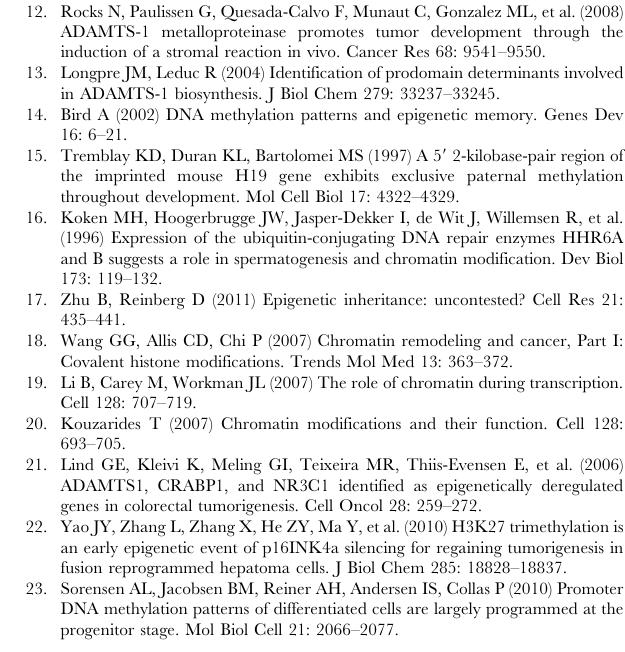
Figure S3 The quantitative ChIP results of Fig. 5, shown by pull-down percentage. (TIF) Figure S4 The protein level of EZH2 is approximately equal in NAF 200N.P10 and NAF 200N.E4.P3 cells. Western analysis was performed using antibody against EZH2 or alpha-tubulin. (TIF) Figure S5 ADAMTS1 mRNA (A) and protein (B) levels are high in CAF 199C and NAF 200N, compared to MDA- MB-468 cells and MDA-MB-231 cells. (TIF) Figure S6 Serglycin promoter-associated H3K27me3, but not H3ace, is reduced in CAF 199C.P10 and NAF 200N.E4.P3, compared to NAF 200N.P10 cells. Chromatin- immunoprcipitation (ChIP) assays using antibody against H3ace or H3K27me3 were performed in indicated cells, followed by PCR amplification with DNA primers against the serglycin promoter region from 2 149 bp to 2 19 bp. Data are shown as mean 6 SD from triplicate experiments. Statistical significance was evaluated by Student’s t-test. * P ,